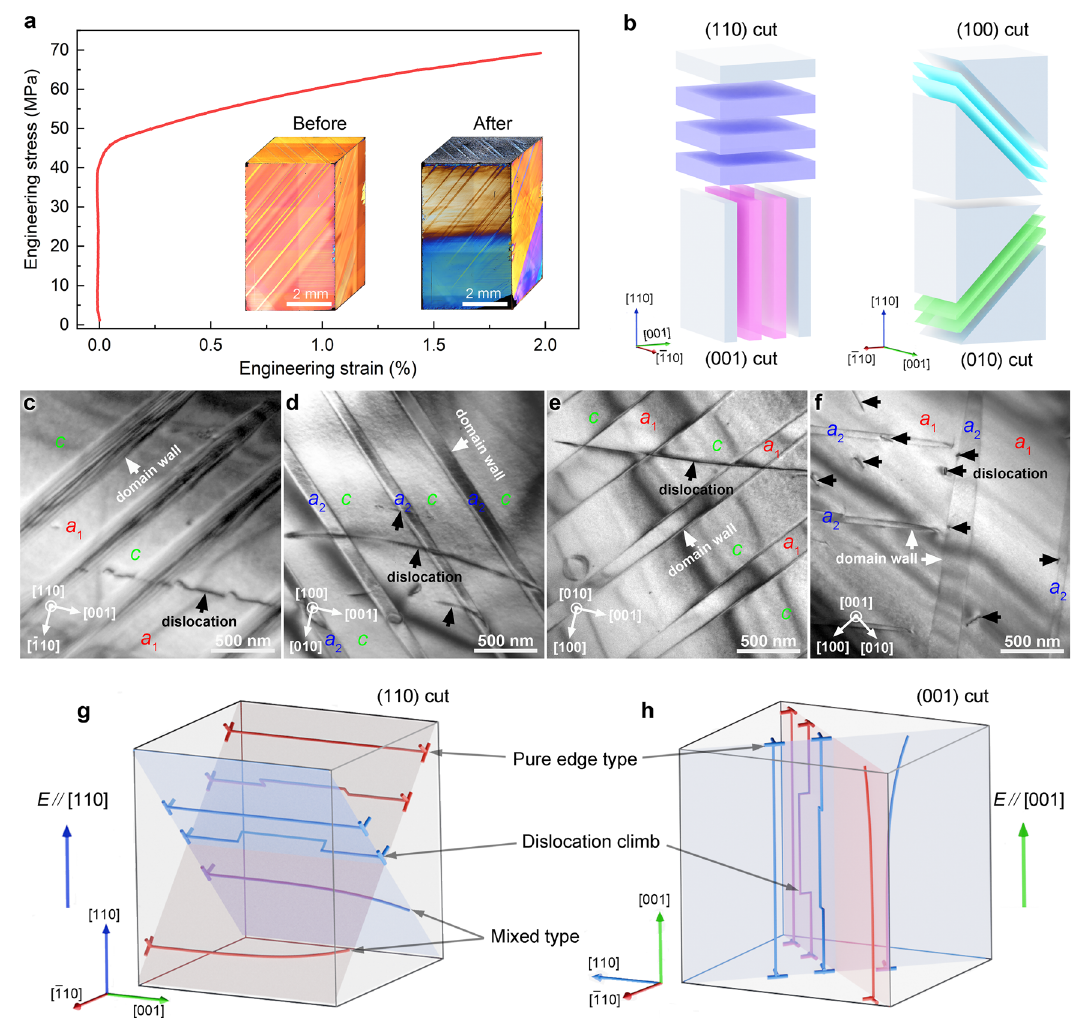
Fig. 1 | Dislocation structure design using high-temperature bulk deformation and characterization. a Stress-strain curve at 1150°C obtained by uniaxial com- pressive plastic deformation with a loading-rate of 0.2Ns – 1 . We selected [110]- loading to introduce dislocations as the critical stress for plastic deformation is much smaller than that of [001]-loading, as shown in Supplementary Fig. 2c. The insets reveal the typical domain structure with 90° domain walls before and after deformation. TEM images were taken after preparing samples by slicing the deformed samples into pieces parallel to (110), (100), (010)aswell as(001)planes, seeextractingslicesin b .Bright- fi eldTEMimagesofdislocationsthatformedinthe deformed BaTiO 3 crystal, when imaging the c , (110) plane, ( d , e ), (100) and (010)